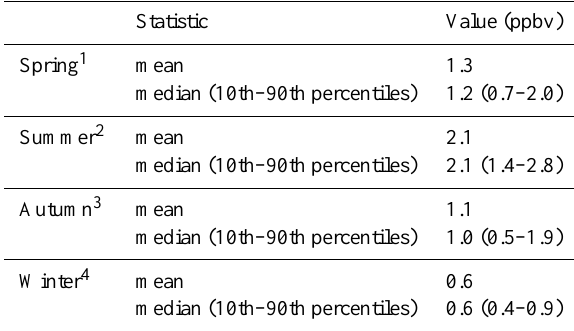
Table 1. Seasonal acetone mixing ratios measured at the KCMP tall tower.